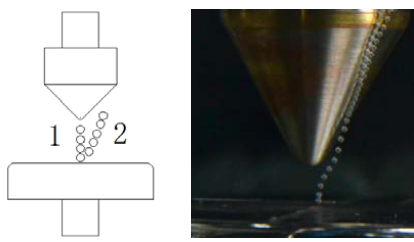
Figure 4. The bubbles of the cone-plan electrodes, where 1 are the initial bubbles; 2 are the bubbles affected by the electric field. The left picture is the schematic diagram and the right one is the real photo of the bubbles affected by the electric field.